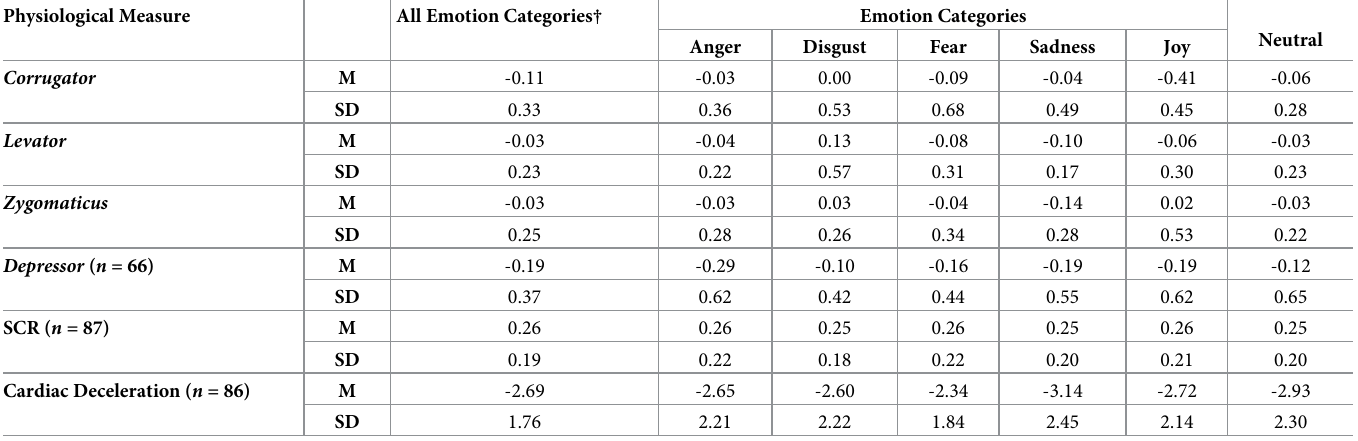
Table 3. Physiological responses across participants ( N =